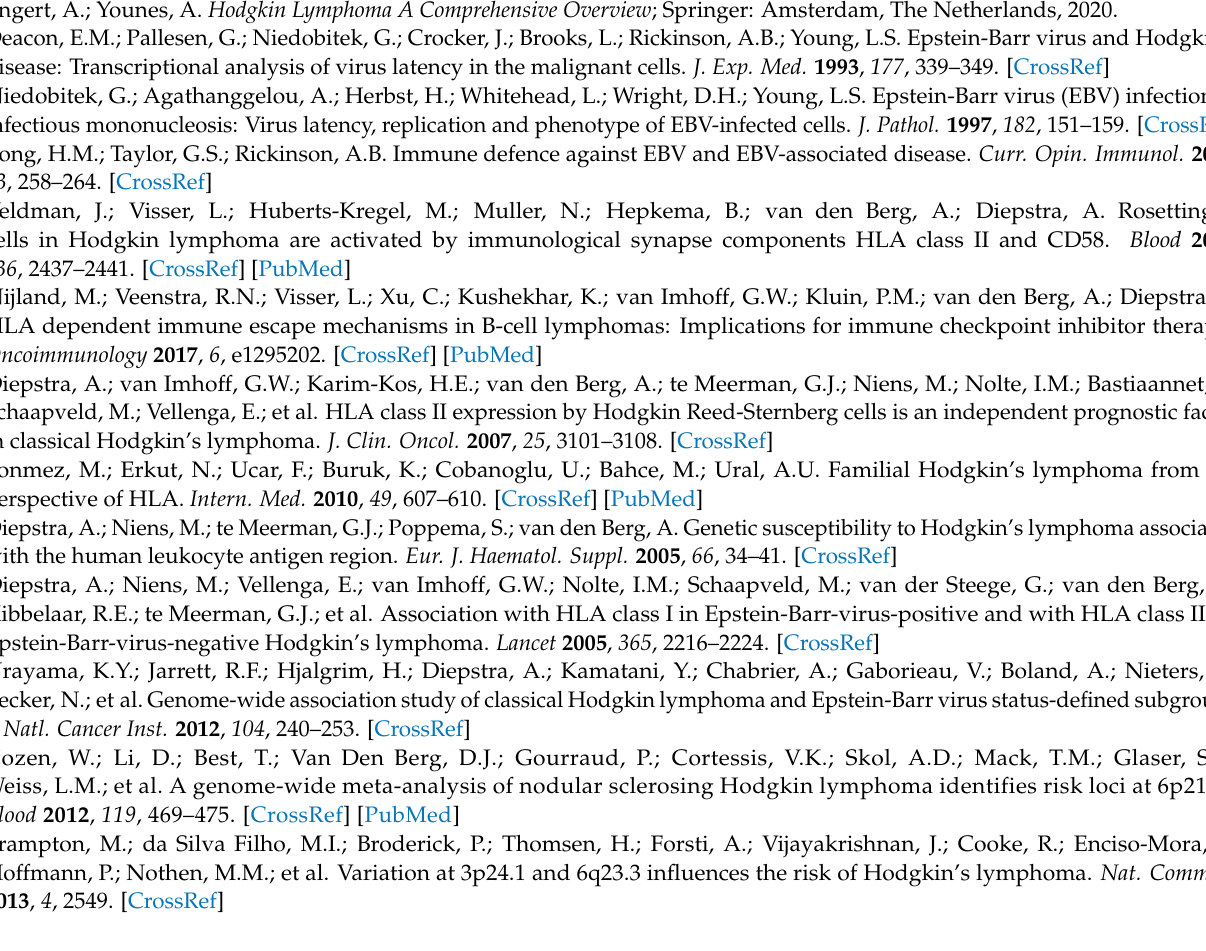
Table S1: Number of subjects in meta-analysis and HLA expression analysis, Table S2: Frequencies of HLA alleles in patients and